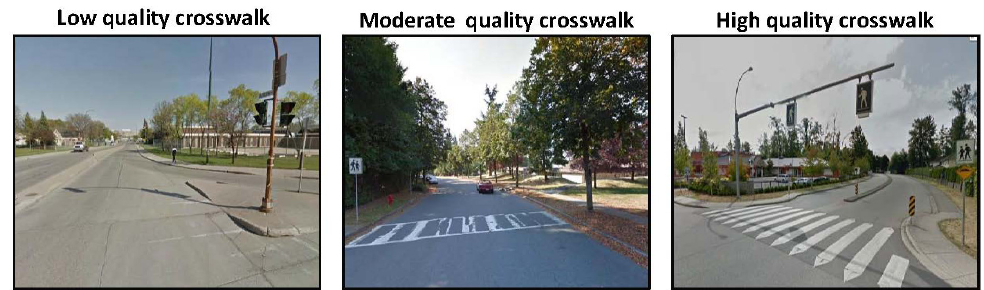
Figure 1. Google Street View images of crosswalks.